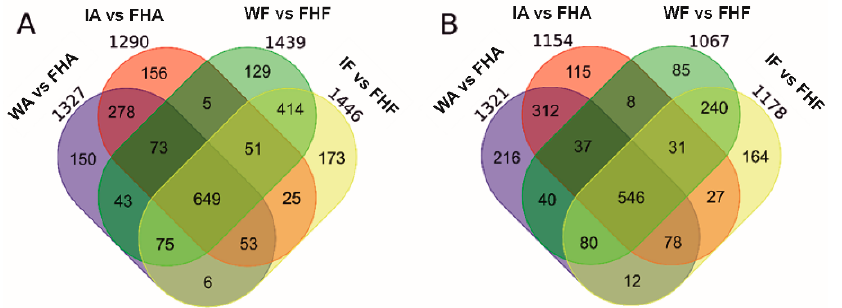
Figure 2. Venn diagrams showing the distribution of the differentially expressed genes (DEG, edgeR, BH p -value adjustment α ≤ 0.05) induced ( A ) or repressed ( B ) in the flavedo and albedo tissues of the Navelate oranges inoculated with 10 µL of P. digitatum (10 4 conidia mL − 1 ) (I, infected fruit) or 10 µL of water (W, control mock-wounded fruit). After infection or wounding (control of infection), fruit were left in the dark at 20 °C for 1 d (1 dpi). FHF: freshly harvested fruit flavedo; FHA: freshly harvested fruit albedo; WF: wounded flavedo at 1 dpi (control of flavedo infection); WA: wounded albedo at 1 dpi (control of albedo infection); IF: infected flavedo at 1 dpi; IA: Infected albedo at 1 dpi. The expression levels of the up- and down-regulated genes in the wounded (control) and infected fruit were compared to the levels of the freshly harvested fruit, and met a cut-off of |Log 2 FoldChange| ≥ 1. The numbers outside ellipses are the sum of all the induced ( A ) and repressed ( B ) genes under each particular condition.